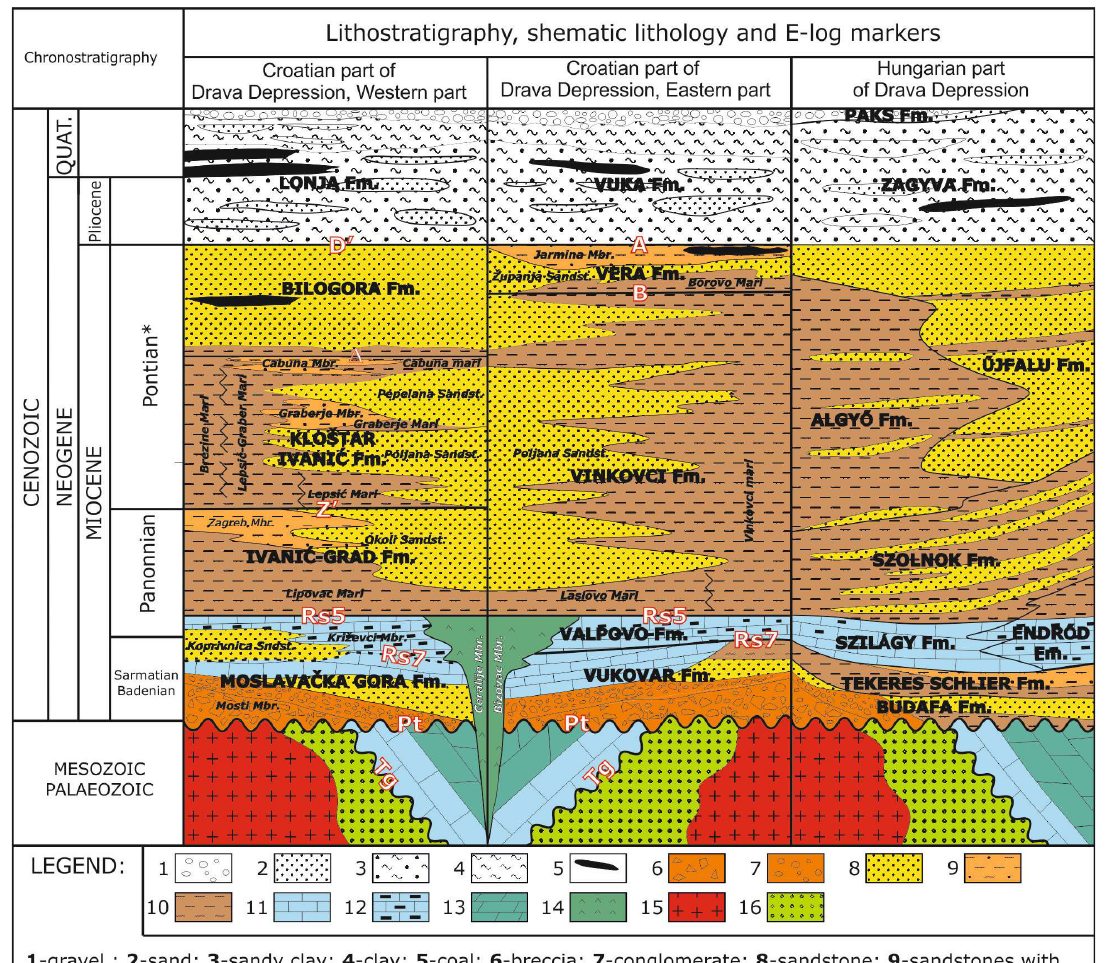
Figure 8. Schematic lithostratigraphic columns of the Drava Depression [36].